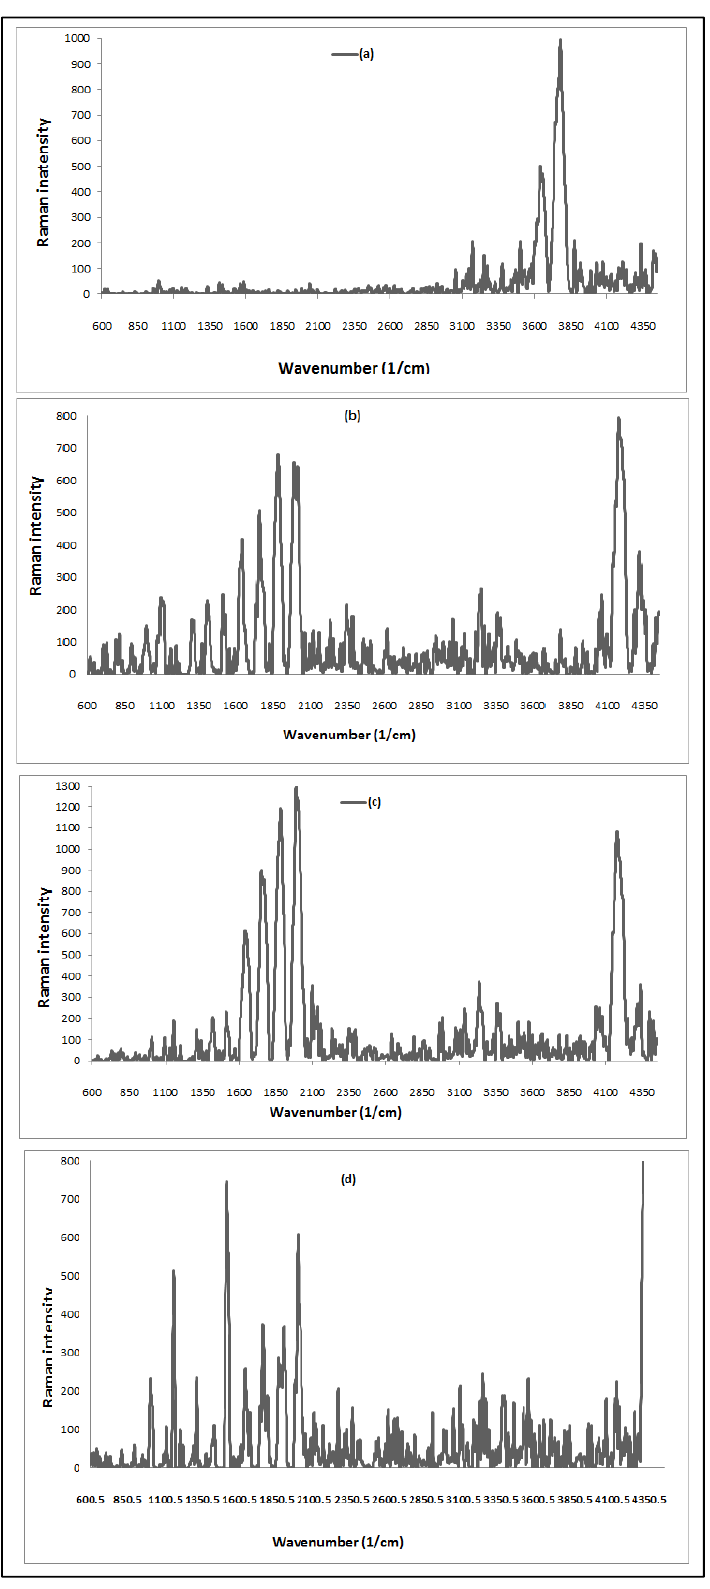
Figure 2. Raman spectrum for spectra for: ACDB before adsorption ( a ); ACDB after adsorption ( b ); LFB before adsorption ( c ); LFB after adsorption of IV2R dye ( d ).